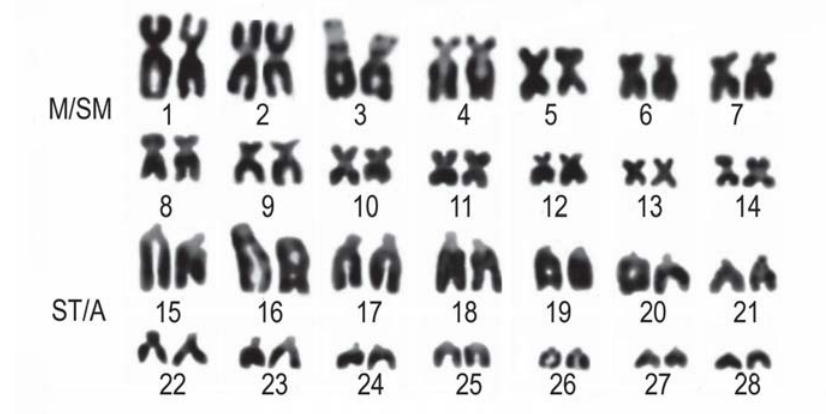
Fig. 1 . Karyotype of Arapaima gigas showing chromosome constrictions in pair 3. Bar = 5